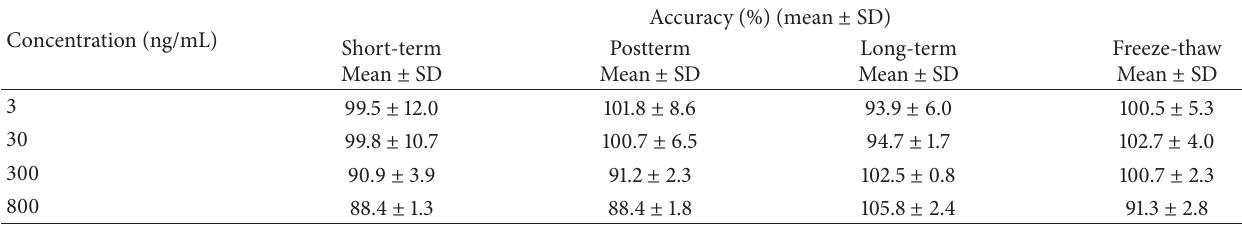
Table 2: Stability data of epimedin C in rat plasma ( 𝑛 = 5 ).